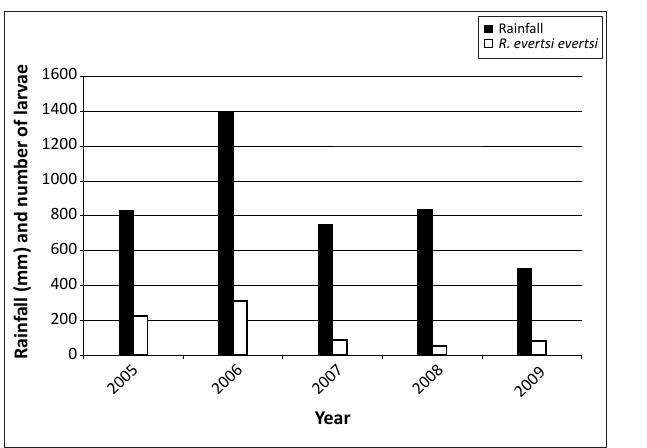
FIGURE 3: Annual rainfall and numbers of questing Rhipicephalus evertsi evertsi FIGURE 4: Annual rainfall and numbers of adult Rhipicephalus evertsi evertsi and Rhipicephalus follis on cattle at Döhne and Campagna (February 2007 – January larvae collected at Döhne and Campagna (2005–2009). TABLE 3: Adult ticks collected from Bonsmara and Nguni cattle at Döhne, and Bonsmara cattle at Campagna (February 2007 to January 2010). Tick species Total number of adult ticks collected Number of adult ticks from each breed Males Females Bonsmara Döhne Nguni Döhne Bonsmara Campagna